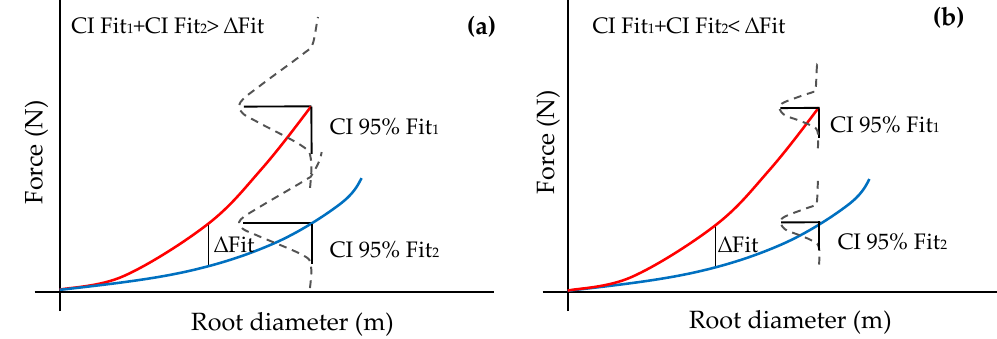
Figure 3. Schematic view of the definition of ∆Fit and sum of the confidence interval at 95% (CI-95%), showing an example of overlapping distributions (a), and significantly different distributions (b).